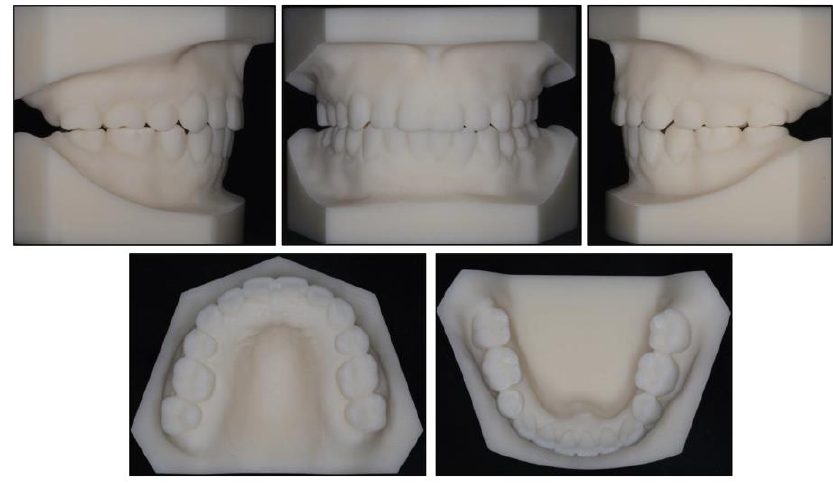
Figure 8. Post-treatment dental casts.